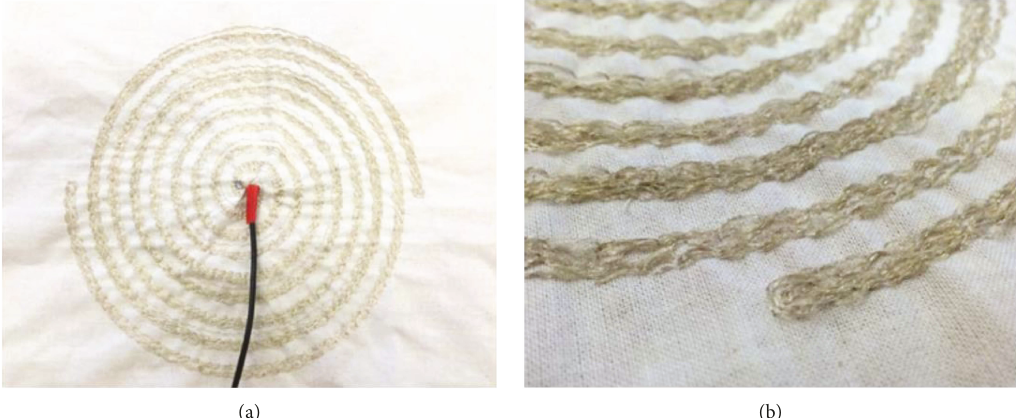
Figure 9: Embroidered spiral antenna. (a) Top view. (b) Zoomed-in view